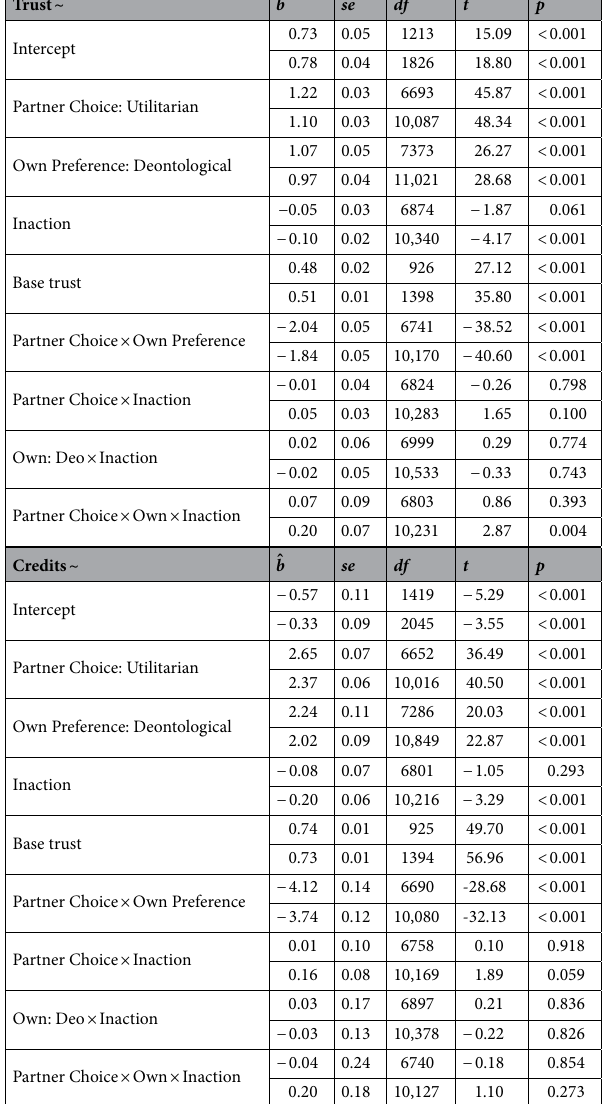
of the dummy variables: (1) Partner choice: 1 = Utilitarian, 0 = Deontological; (2) Own preference (i.e., participant’s own preference): 0 = Utilitarian, 1 = Deontological; (3) Action frame: 1 = Inaction, 0 =